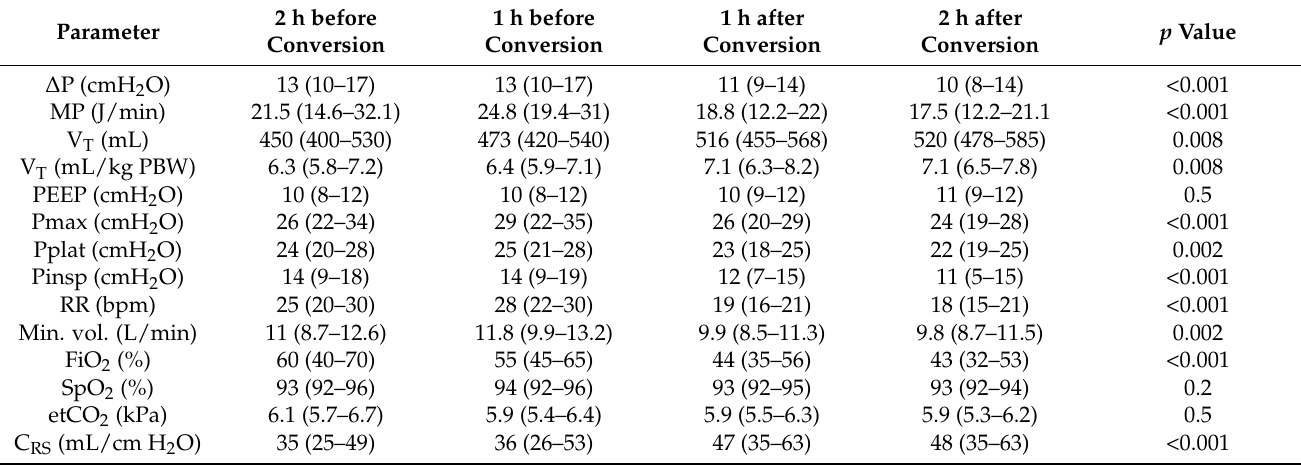
Figure 4. Scatterplot of individual changes in ( a ) tidal volume (ml/kg PBW) and ( b ) driving pressure (cm H 2 O) when the patients were switched from conventional ventilation, at 1 h before conversion, to INTELLiVENT-ASV (V T , INTELLiVENT-ASV-V T , INTELLiVENT-ASV; and Δ P, INTELLiVENT-ASV- Δ P, conventional) 2 h after conversion. Continuous line; regression lines. Each patient was characterized by a single data point. A negative value for V T or Δ P means that the conversion to INTELLiVENT-ASV resulted in a lower V T or Δ P, and a positive value means that V T or Δ P increased after the conversion. Table 3. Ventilation parameters at the predefined timepoints before and after the conversion from conventional ventilation to